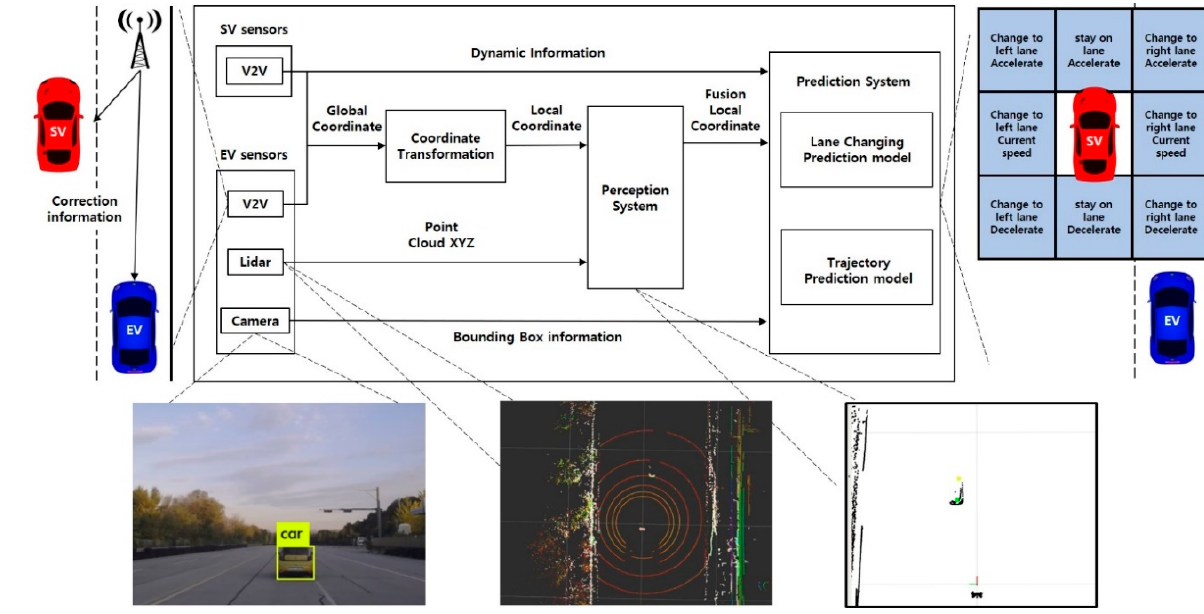
Figure 2. System architecture.